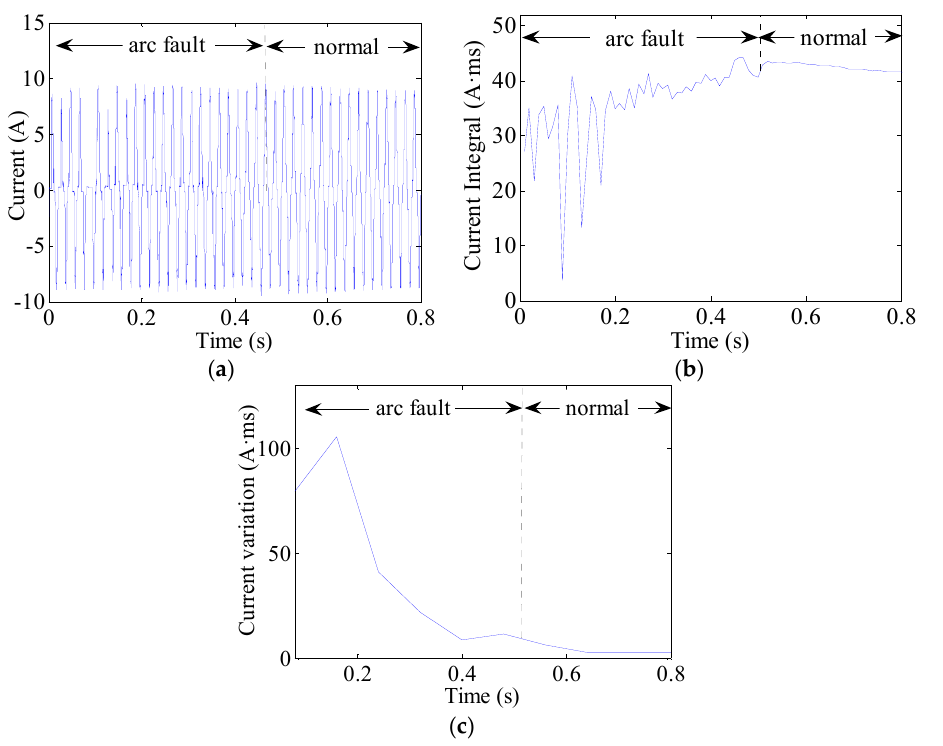
Figure 14. Arc fault current analysis of the vacuum cleaner: ( a ) current waves; ( b ) current periodic integrals; ( c ) current variations.